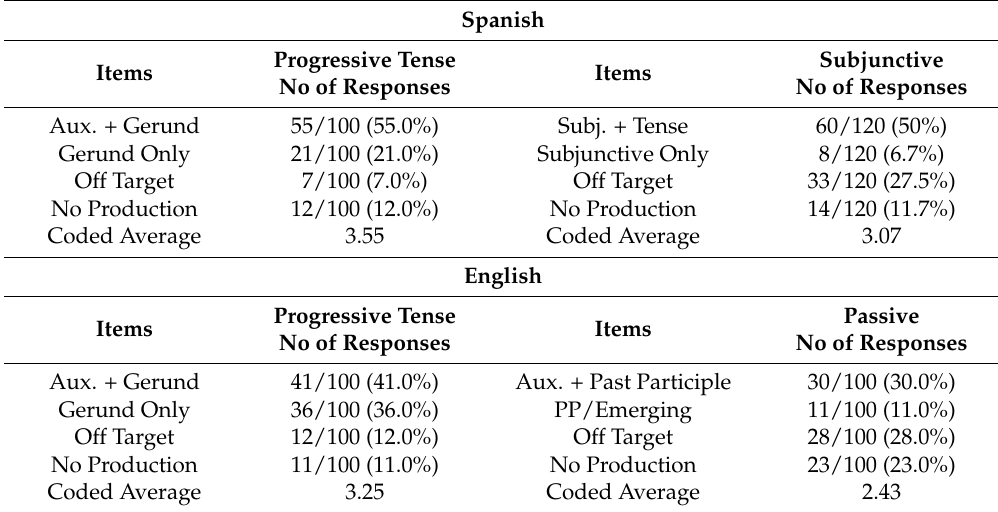
Table 7. Grade 1 Proportion of Responses for Spanish–English